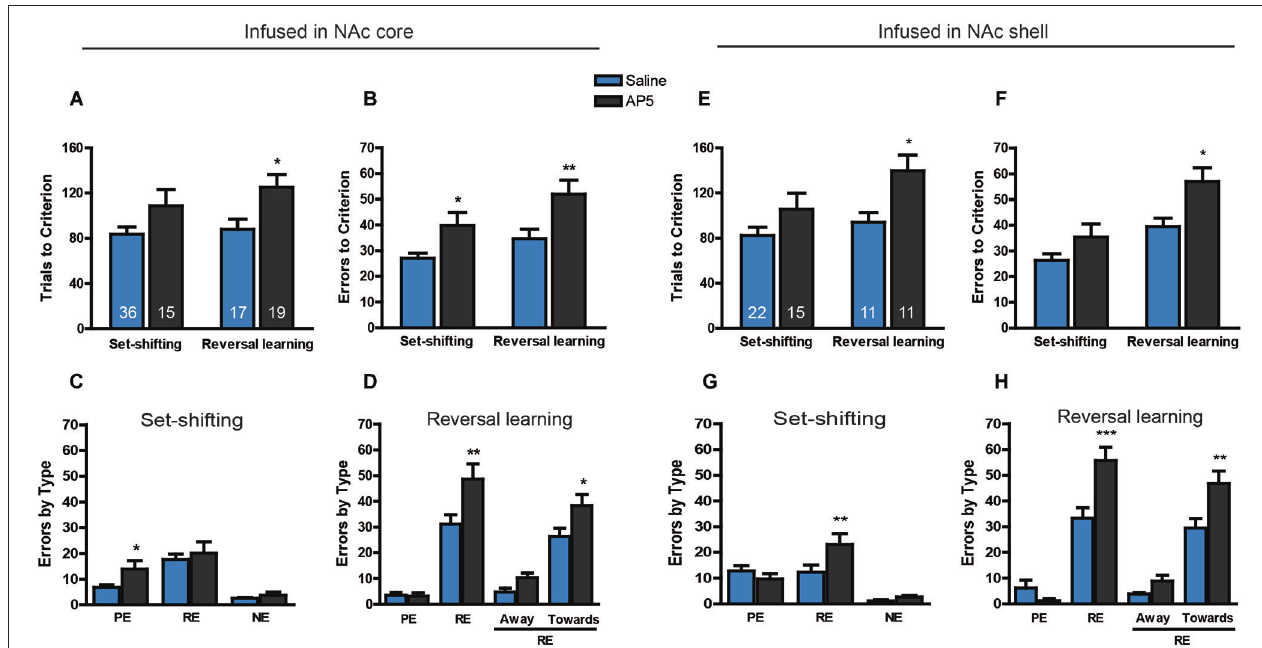
reversal learning (D) in rats that received AP5 treatment in the NAc core. (E) Number of trials and (F) number of errors to reach criterion in the set-shifting and reversal learning tasks following intra-NAc shell infusions. (G,H) Analysis of the types of errors during set-shifting (G) and reversal learning (H) in rats that received AP5 treatment in the NAc shell. * p < 0.05, ** p < 0.01, *** p < 0.001. PE, perseverative error; RE, regressive error; NE, non-reinforced error. During the reversal learning task, regressive errors were further divided into “away” and “toward” the visual cue.